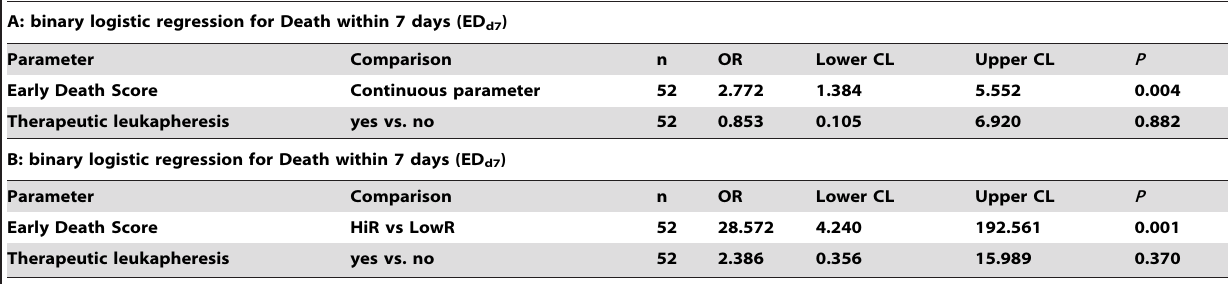
Table 9. A: binary logistic regression for Death within 7 days (ED d7 ). B: binary logistic regression for Death within 7 days (ED d7